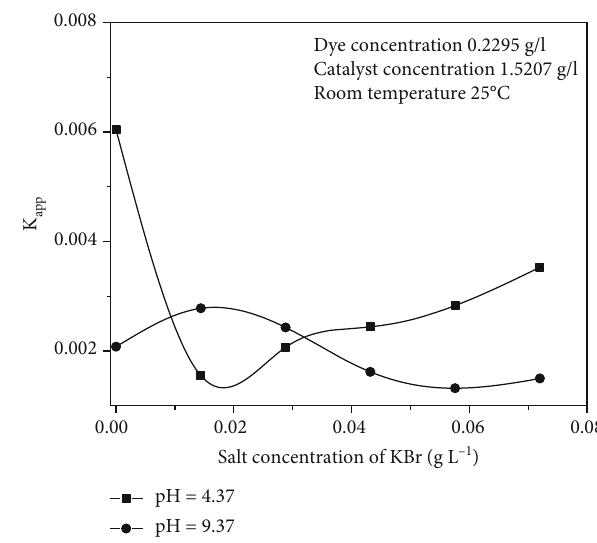
Figure 3: E ff ect of KBr on the apparent rate constant of photocatalytic